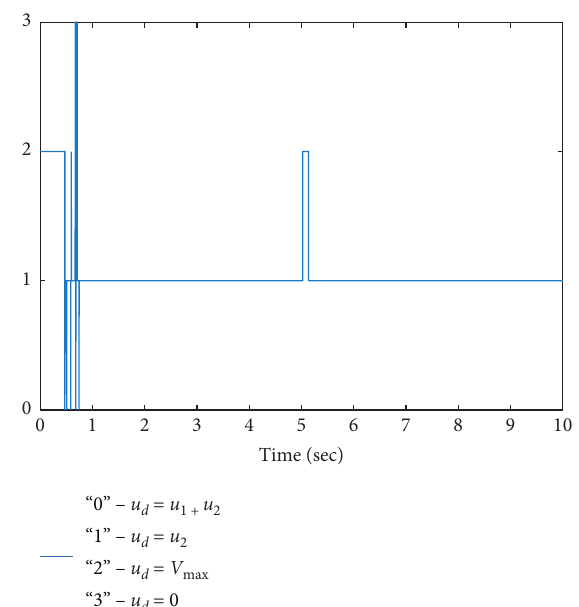
Figure 9: The components of control input on d -axis.